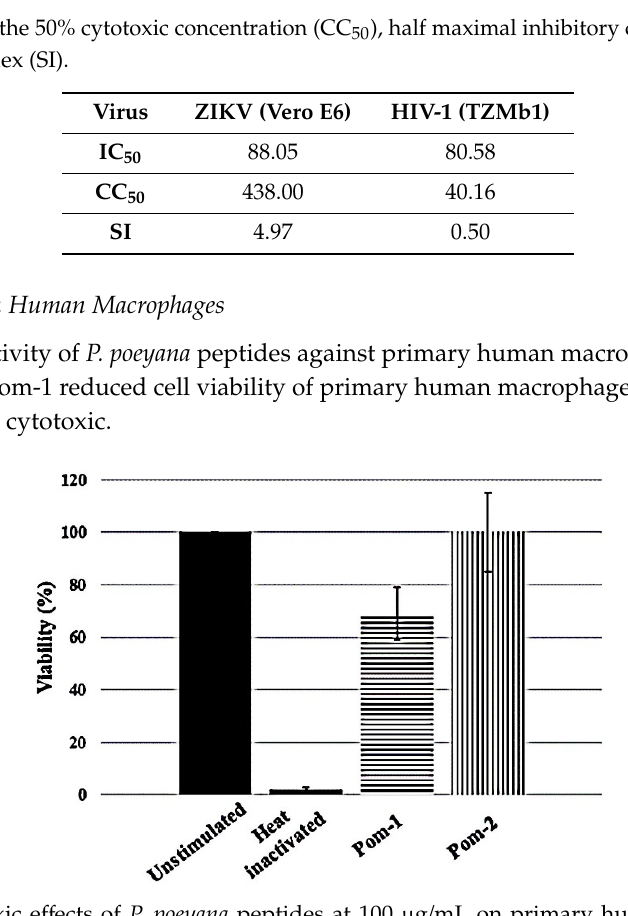
Figure 5. Cytotoxic effects of P. poeyana peptides at 100 µg/mL on primary human macrophages. Experiments were performed in triplicates, and the results are shown as mean values. Standard deviation is shown as vertical bars.